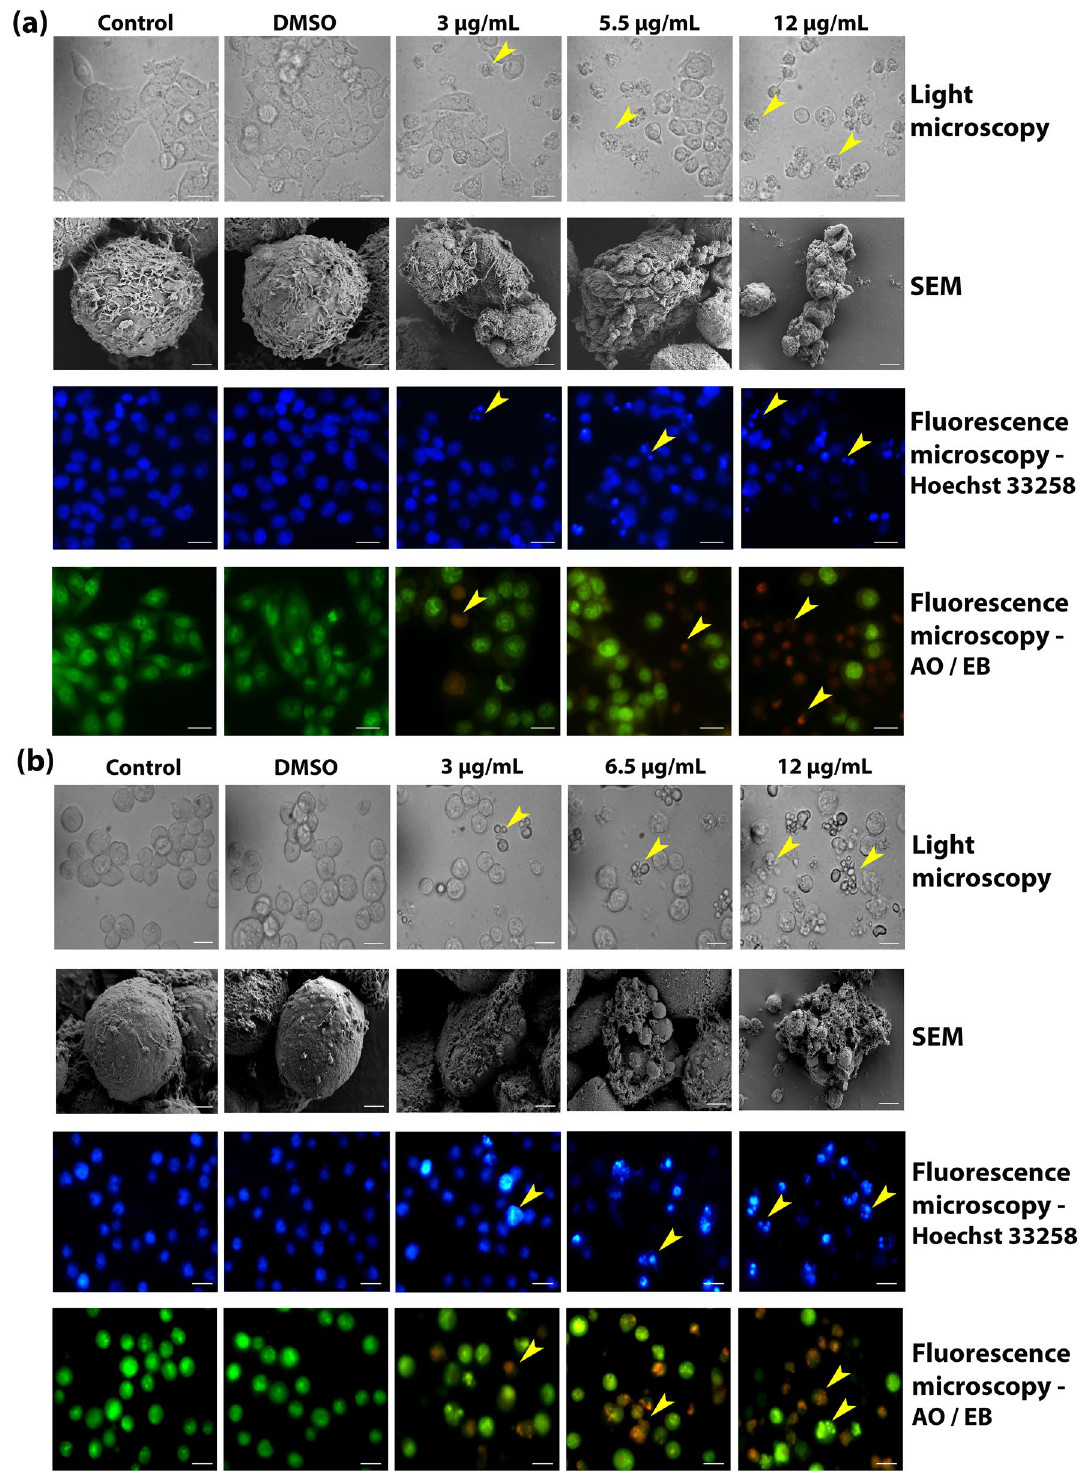
Figure 3. CMRP-induced cytomorphological alterations associated with apoptosis induction detected using light, scanning electron and fluorescence microscopy. ( a ) HCT116 cells and ( b ) K562 cells treated with CMRP for 24 h, following observations under light, SEM and fluorescence microscopy (Hoechst 33258 and AO/EB dual stained cells), for apoptosis- related cytomorphological changes (arrow heads indicate cells undergoing apoptosis). Scale bar: 15 µm for K562 and 20 µm for HCT116 cells for all images except for SEM (scale bar: 2